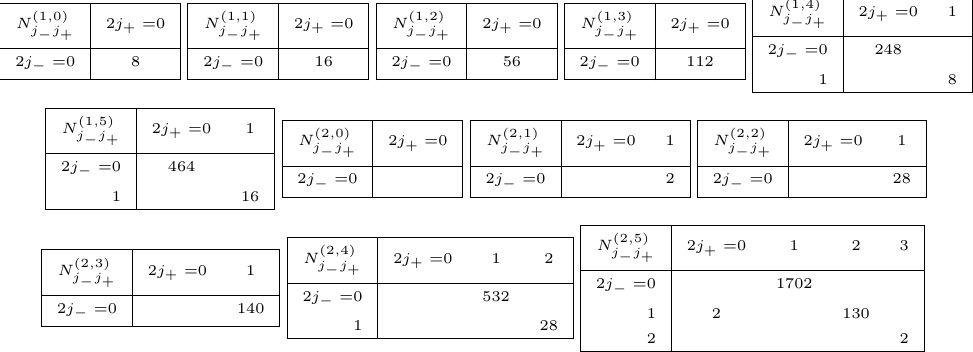
of M 4 , for base degree b (cid:20) 2 and (cid:12)ber degree d (cid:20) j (cid:0) ;j +